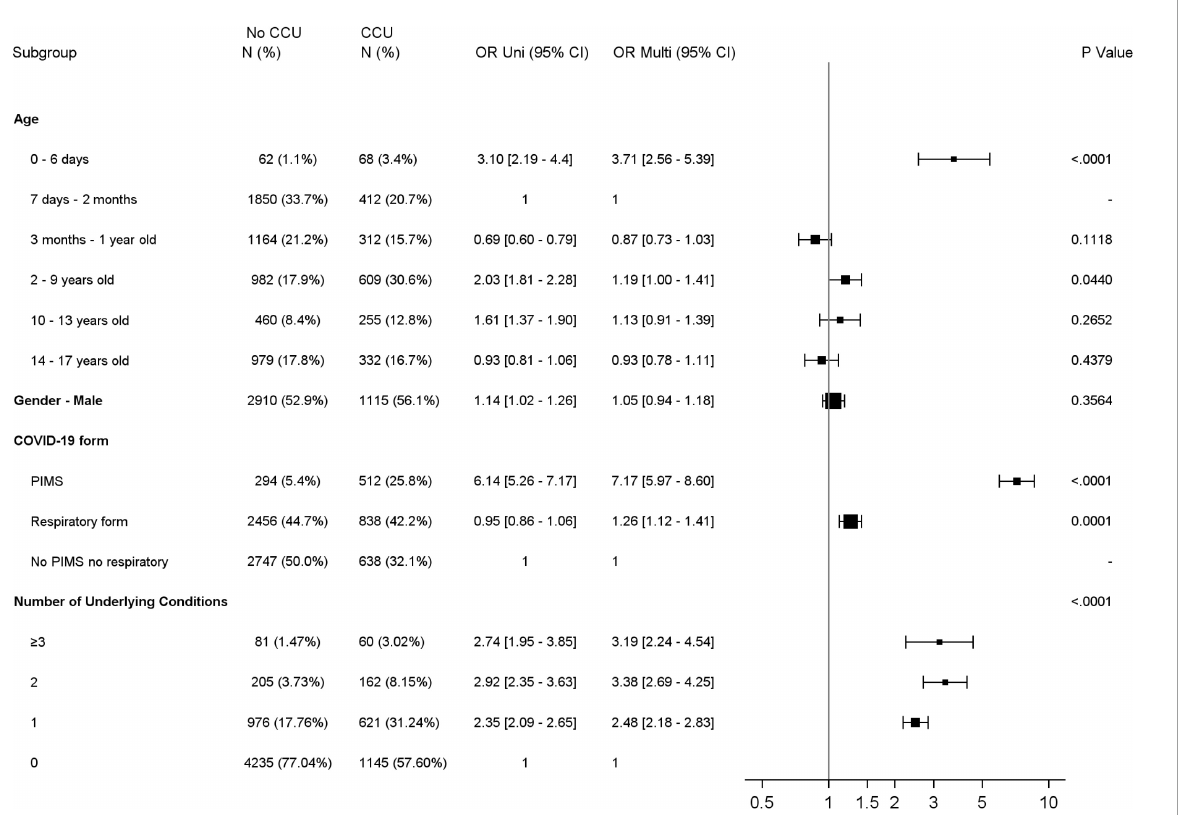
FIGURE3 Forest plot showing the odds ratio using Univariable (Uni) and Multivariable (Multi) Logistic regression analysis for CCU admission for all children. CCU, critical care unit; PIMS, pediatric multisystem inflammatory syndrome; OR, Odds ratio; 95% CI, 95% confidence interval.